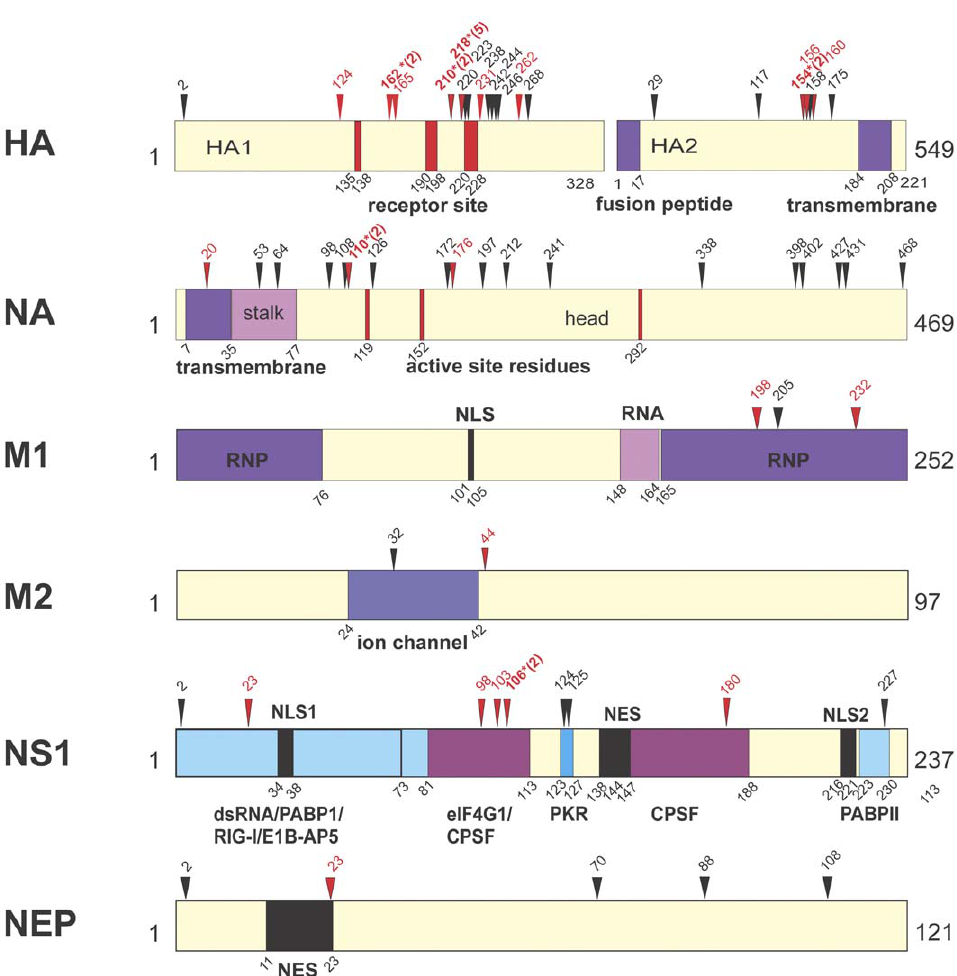
Figure 6. Mouse adaptive mutations on the primary structural maps of HA, NA, M1, M2, NS1 and NEP proteins. Mutations are shown as indicated for Figure 3. The locations of protein binding and active sites are indicated; RNP ribonucleocapsid protein; NLS nuclear localization signal; NES nuclear export signal; dsRNA double-stranded RNA (aa 1–73); PABPI poly-A binding protein 1; PABPII poly-A binding protein II; RIG-I retinoic acid inducible gene I; E1B-AP5, E1B associated protein 5; CPSF cleavage and polyadenylation specificity factor; eIF4GI eukaryotic initiation factor 4GI; and PKR protein kinase R. The following mutations were mapped previously: HA1 G218W, HA2 T156N, NA P468H, M1 D232N, NS1 F103L + V23A, NEP K88R [59].